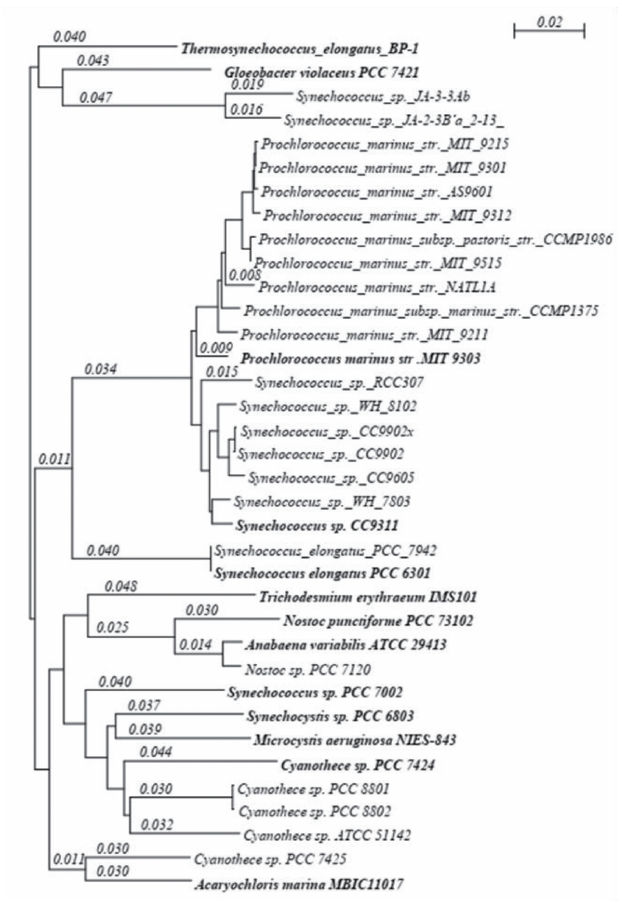
Figure 1: Phylogenetic tree of 16s RNA of 36 bacterial species sequenced at the time of initiation of this work. The bold ones are the species which were selected for our analysis based on the largest genome